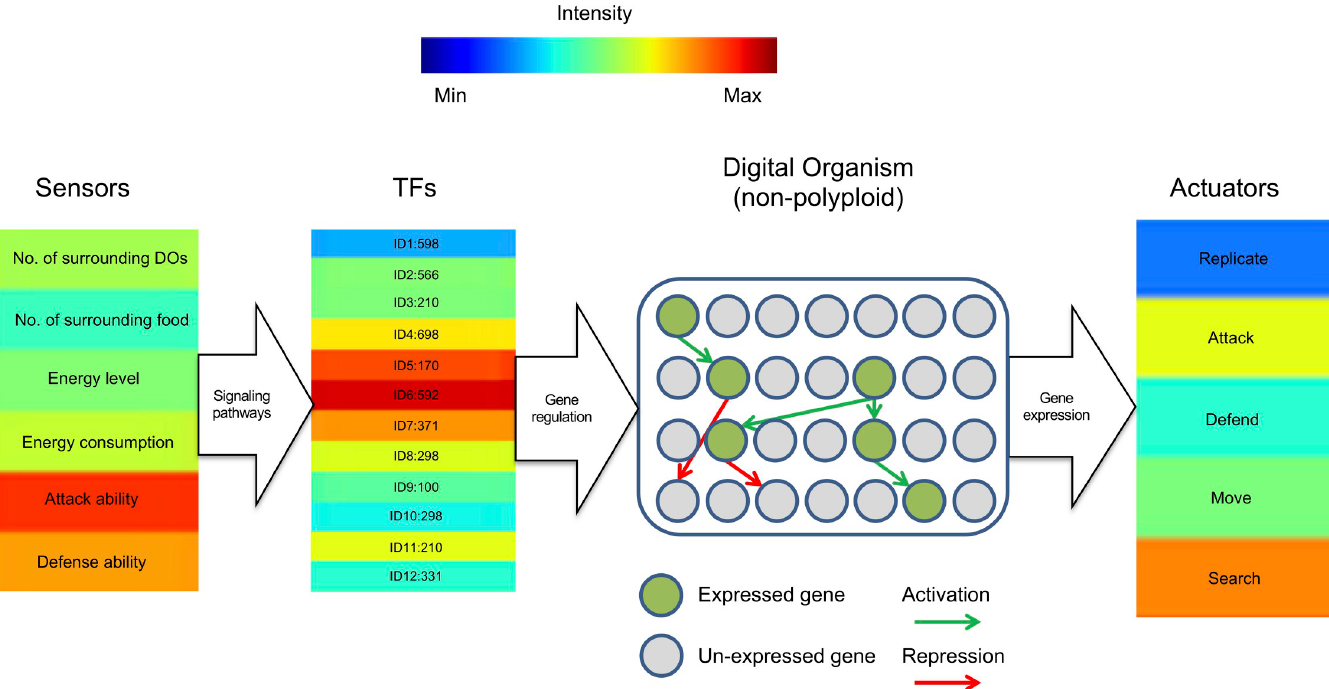
Fig 1. Schematic representation of the different components of our evolution simulation computational framework. At every time step in the simulation, the values of the sensors are converted by means of linear equations into a number (see Fig 2D). When this number matches the specific identity number of a particular gene product, there is an increase of its corresponding concentration level. The concentration level of all gene products determines the overall behavior of a DO, which is in turn defined by the set of possible actuators, each one encoded by its corresponding structural genes.